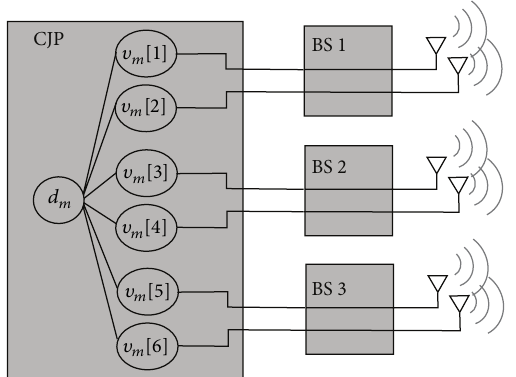
Figure 9: Scheme of cooperation between 3 BSs with 2 pAEs per BS. To do the central joint processing, a central unit calculates the joint precoding weights v 𝑚 [1],. .. , v 𝑚 [6] to transmit the symbol 𝑑 𝑚 for MS 𝑚 .